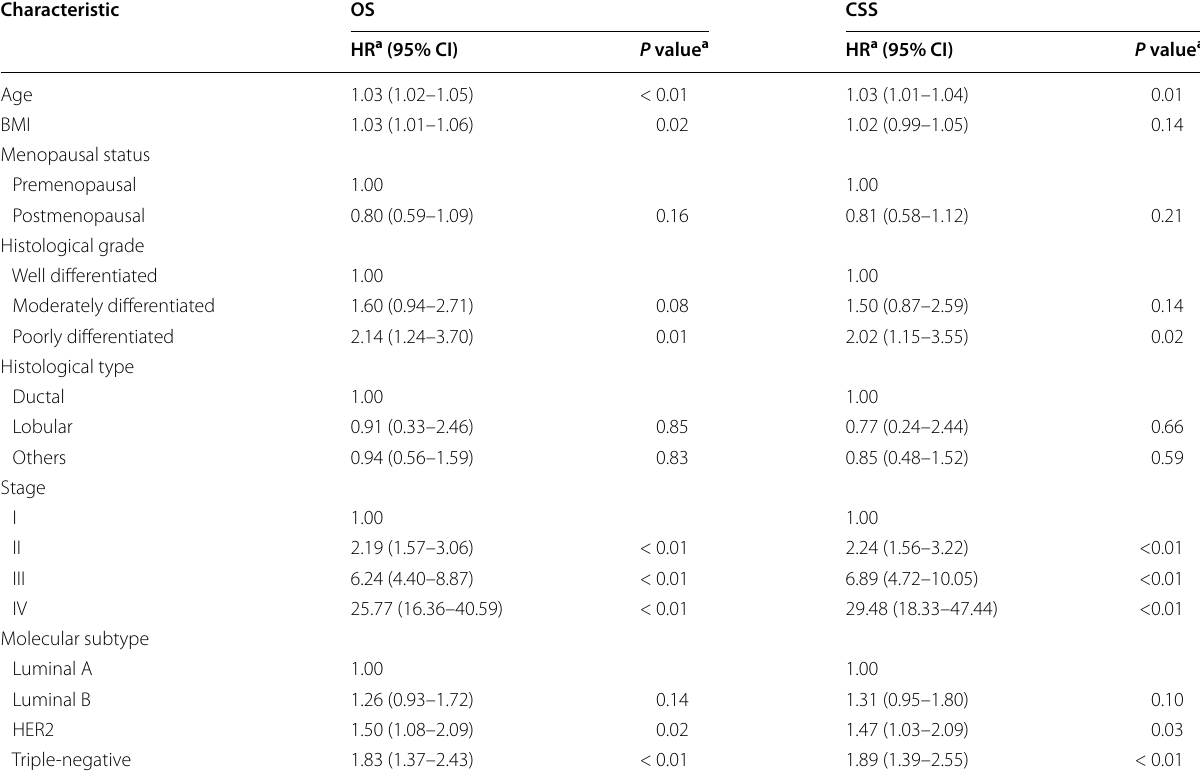
a HRs, 95% CIs, and P values were calculated using the adjusted multivariate Cox proportional hazard model OS overall survival, CSS cancer-specific survival, HR hazard ratio, CI confidence interval, BMI body mass